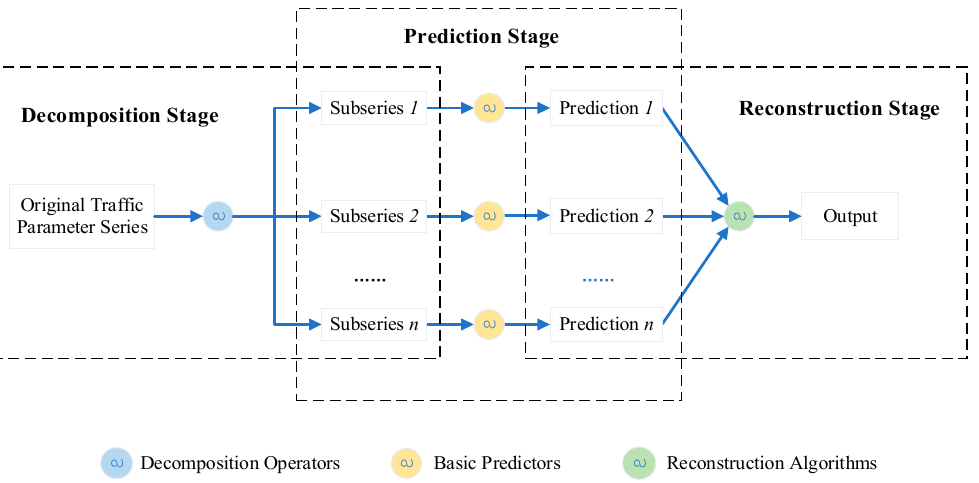
Figure 1. General procedure of decomposition–reconstruction or divide-and-conquer.